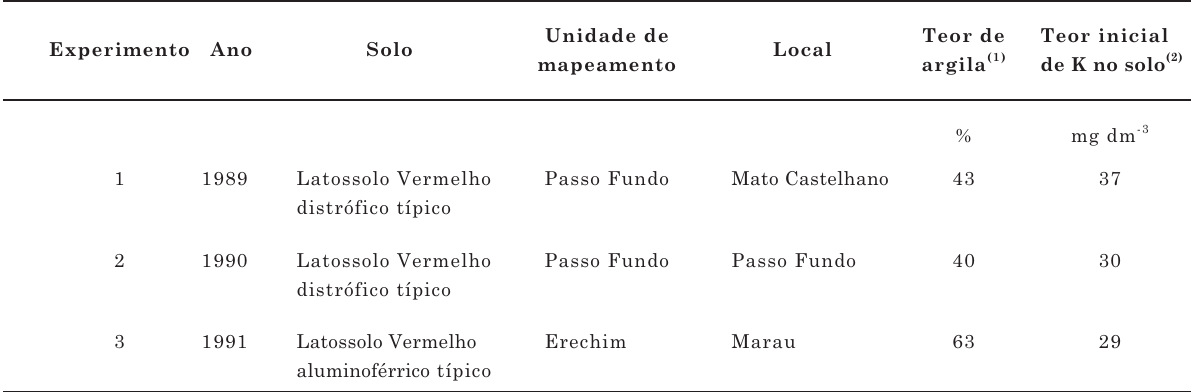
logo depois. Durante o desenvolvimento da cultura do trigo não foi observado déficit hídrico. A cultivar foi BR-23. O delineamento experimental foi de blocos casualizados com quatro repetições. O tamanho das parcelas foi 5 x 18 m. Na análise conjunta dos dados de resposta do trigo a K e para derivar os modelos de regressão, empregou-se o procedimento Stepwise